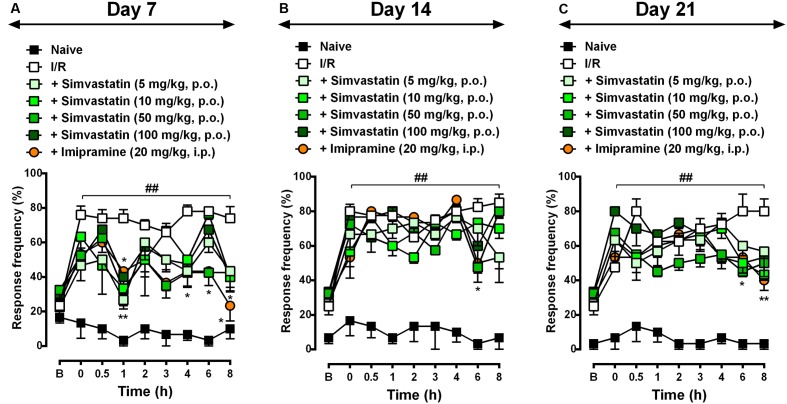
Simvastatin single treatment reduced mechanical hyperalgesia during CPIP. CPIP was induced via a 3-h hindpaw I/R injury, and animals treated with different doses of simvastatin (5, 10, 50, and 100 mg/kg, 1x/day, p.o.) evaluated at 7 (A), 14 (B), and 21 (C) days after nerve injury. Imipramine (20 mg/kg, i.p.) was used as positive control drug. Response of frequency of the ipsilateral withdrawal thresholds assessed at several time-points by von Frey hair test. (B) Baseline withdrawal threshold before I/R injury. Data are expressed as mean ± SEM (n = 6/group), and are representative of two independent experiments. ##P < 0.001 vs. naïve group, ∗P < 0.05 and ∗∗P < 0.001 vs. I/R group (two-way ANOVA followed by Bonferroni’s test).